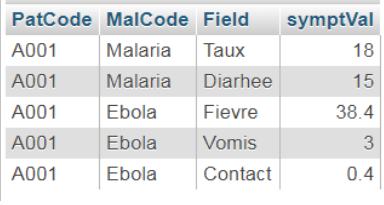
Fig. 5. Fact base database.